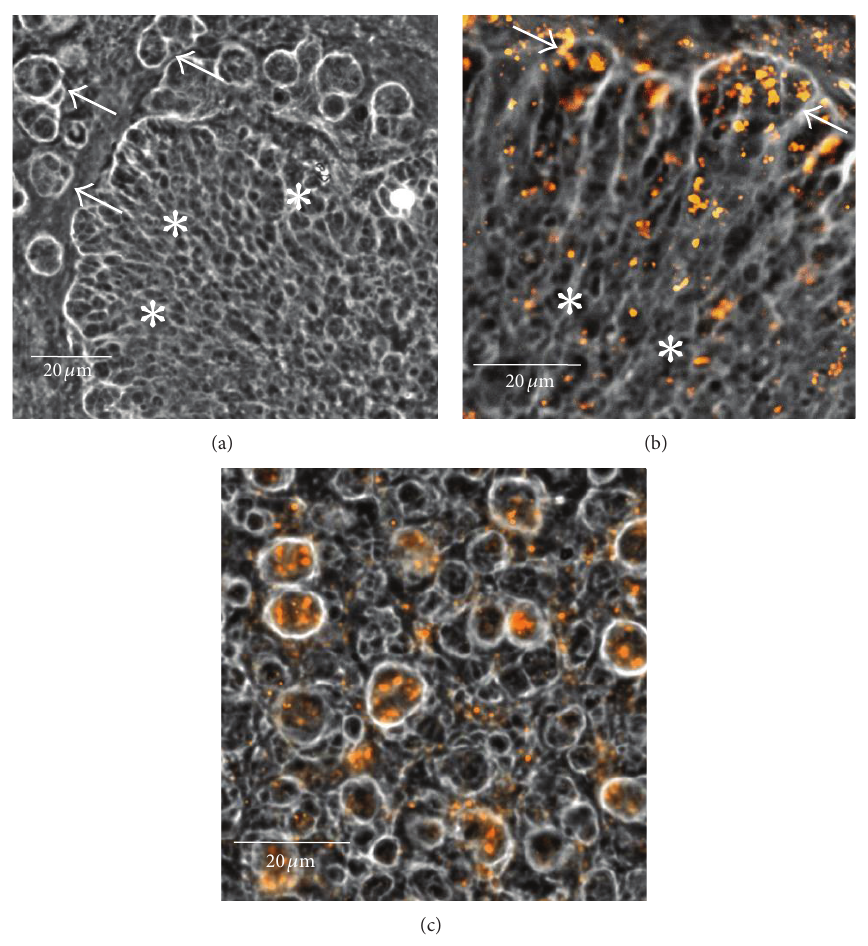
Figure 1: Light micrographs of semithin sections after immunofluorescence staining with anti-MCR antibodies (merged fluorescence/phase contrast images). (a) One large, cauliflower-like aggregate (lower right, the whole aggregate marked by three asterisks) surrounded by small globular aggregates (arrows) in an unstained semithin section (phase contrast microscopy). (b) Periphery of a large aggregate. The cell density at the periphery of the aggregate (arrows) is higher than in the central area (asterisks). (c) Small aggregates after fluorescence